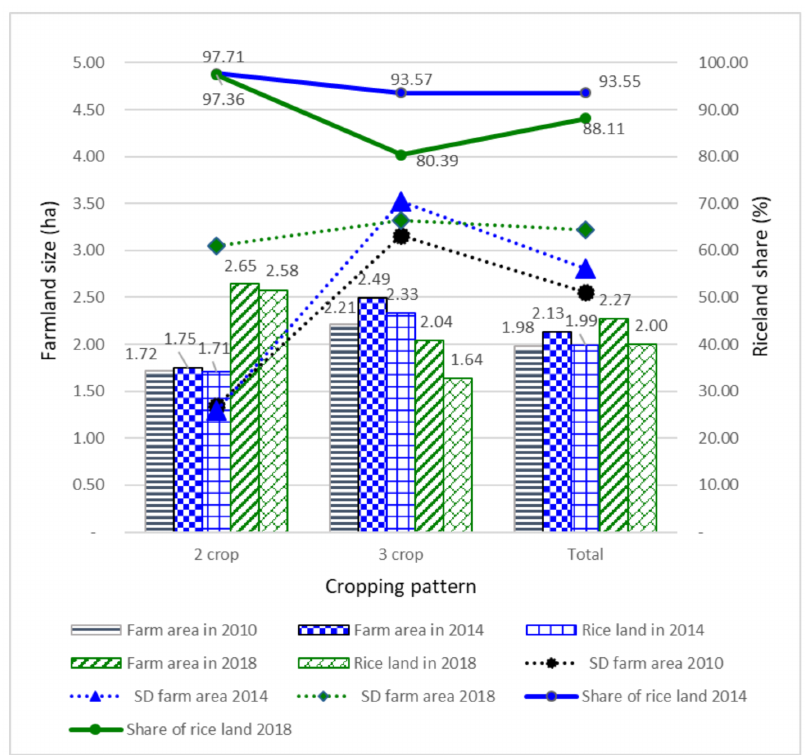
Figure 16. Change of farmland size / household from 2010 to 2014, and 2018 in the Mekong Delta. Two-crop, three-crop, all areas’ average, and share of rice land in all farmland. Source: created from survey data in 2014 and 2018 by the Mekong Delta Development Research Institute of Can Tho University